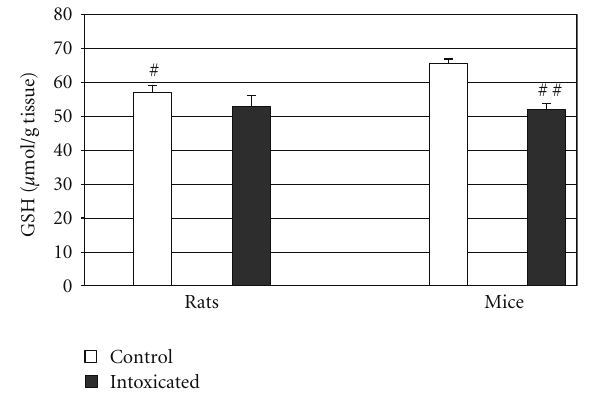
Figure 2: Concentration of reduced glutathione in testicular homogenates of rats and mice, # P = 0 . 05 in comparison to the mice control, ## P = 0 . 0029 in comparison to the